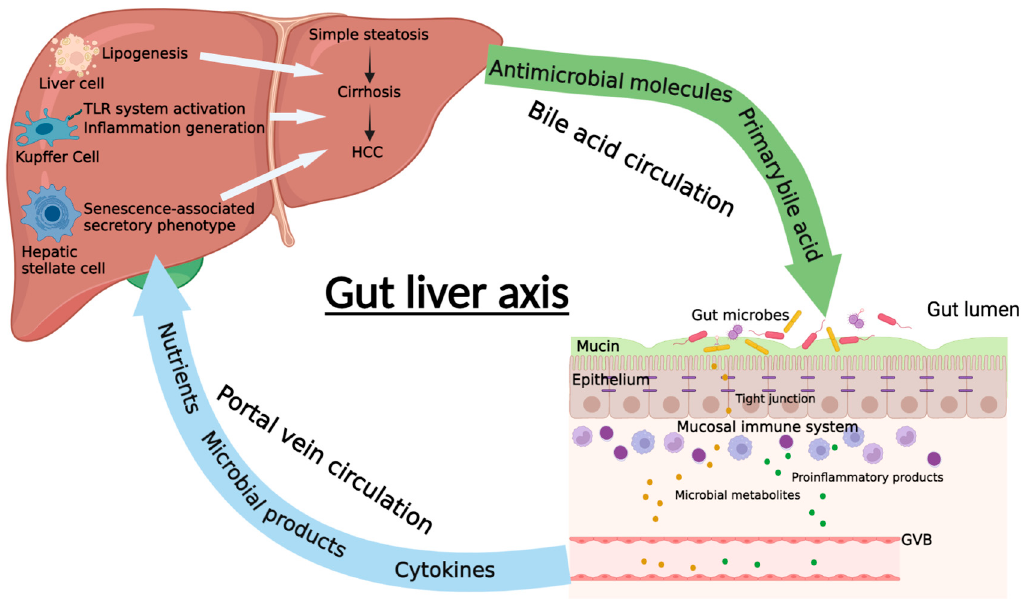
Figure 1. The diagrammatic representation of gut–liver axis. The communication between gut and liver in NAFLD is the intestinal barrier, which is composed of mucus layer, intestinal epithelium, mucosal immune system, and gut vascular barrier (GVB). The gut microbiota and their metabolites as well as some proinflammatory products can pass through the intestinal barrier and enter the liver through the portal system. In the liver, they can promote or inhibit the progression of NAFLD through different mechanisms. Meanwhile, liver can also regulate intestinal function and gut microbiota balance through the bile acid circulation, which is an important enterohepatic circulation in regulating NAFLD (Created with